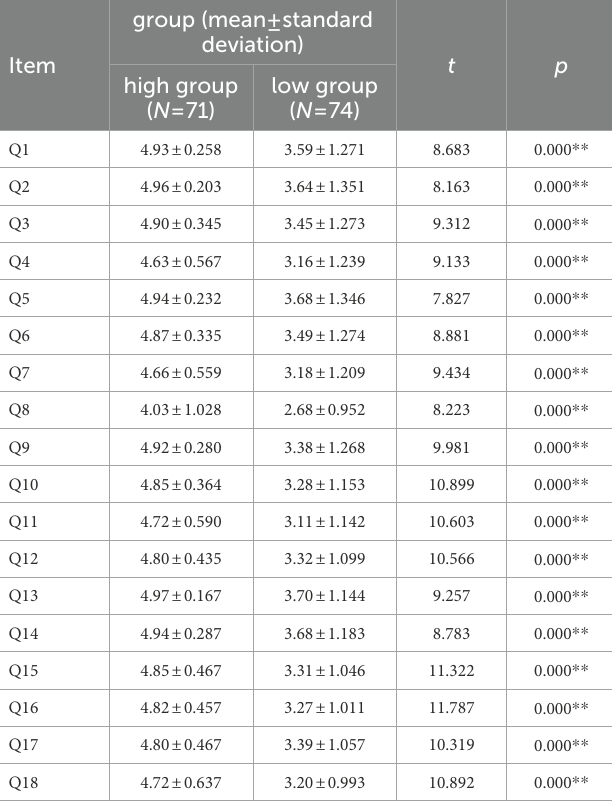
TABLE 1 Project analysis